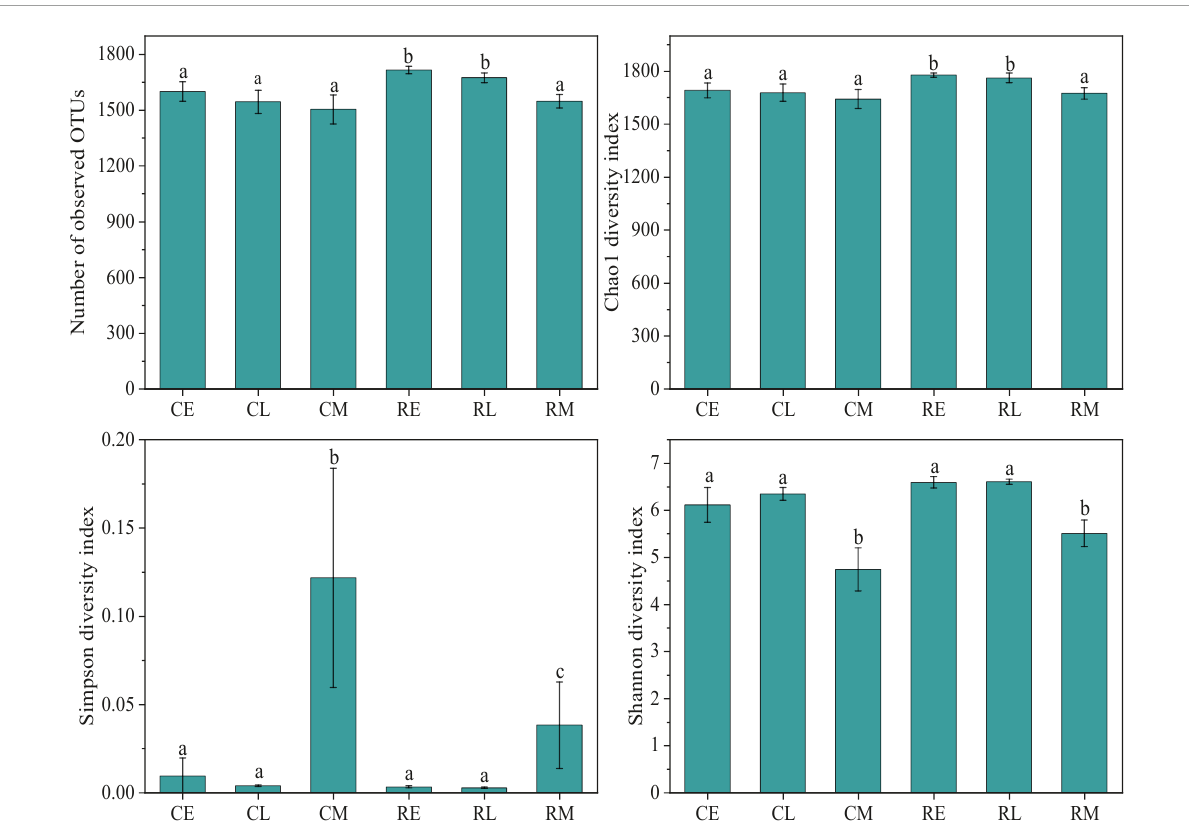
FIGURE1 Bacterial alpha-diversity index in different groups (CE, CL, and CM represent the tobacco prosperous long-term, topping, and mature stages, respectively, in the tobacco continuous cropping system; RE, RL, and RM represent the corresponding stage in tobacco-rice rotation cropping